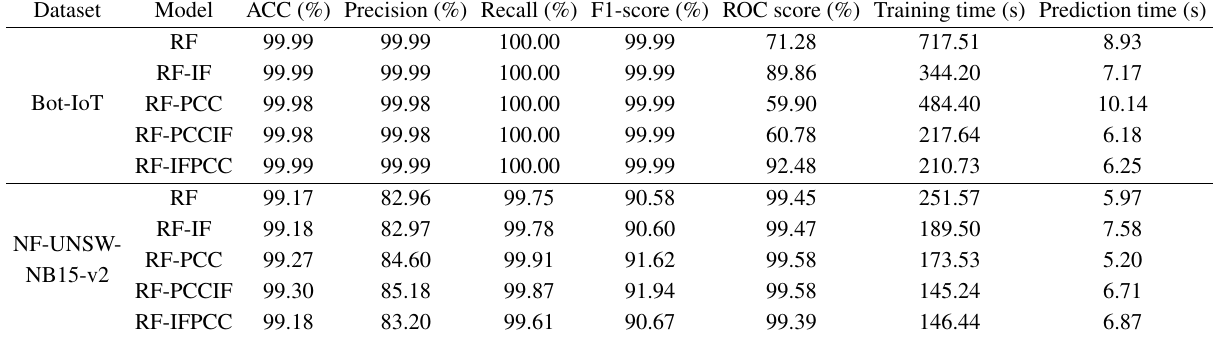
Table 6 A summary table of performances metrics on Bot-IoT and NF-UNSW-NB15-v2